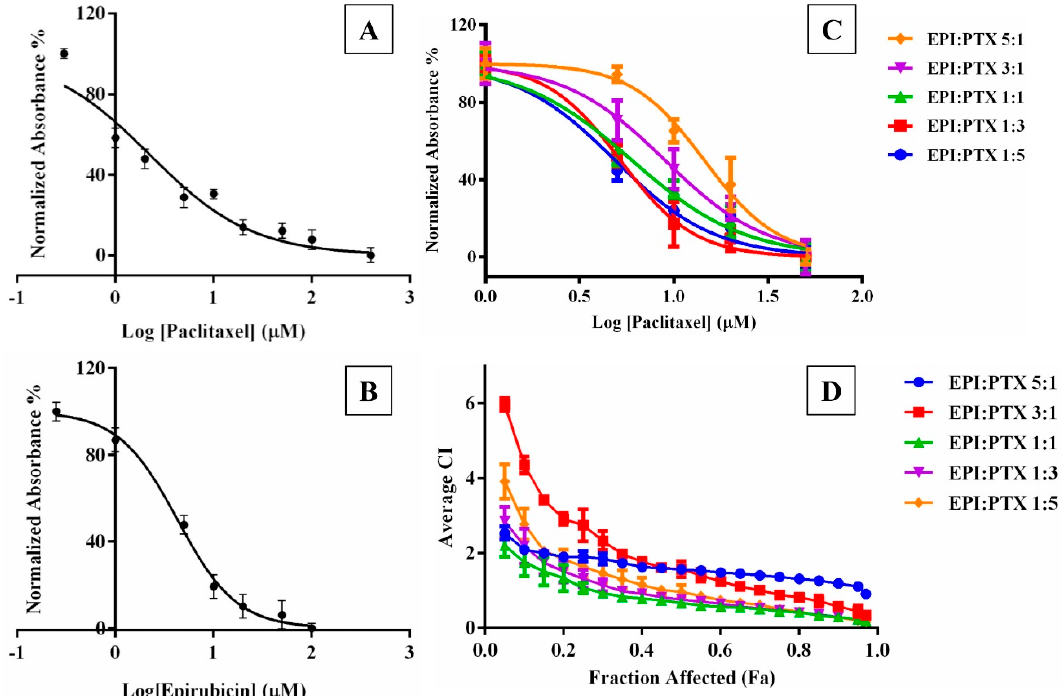
Figure 1. Dose response curve for ( A ) Paclitaxel and ( B ) Epirubicin in A549 cell line as a monotherapy as well as in combination ( C ) at 5 fixed ratios EPI:PTX (5:1, 3:1, 1:1, 1:3, 1:5), ( D ) Combination index (CI) values for the combination at different fraction affected (Fa) in cancer cells. Fa represents the fraction of cells that results in cell death by the drug combination. Data shown as mean ± SD (n = 3).